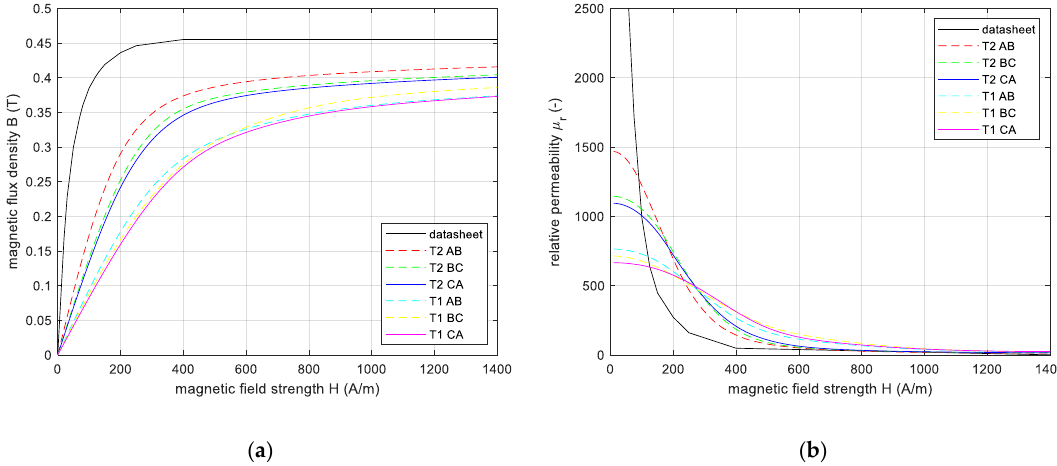
Figure 7. Synthesis of equivalent B ( H ) measurement: ( a ) equivalent anhysteretic B ( H ); ( b ) equivalent relative permeability µ r ; curves based on 3C90 datasheet (black) and measurement: T2 supply of A and B windings (red), T2 supply of B and C windings (green), T2 supply of C and A windings (blue)—the same as in Figure 6, T1 supply of A and B windings (cyan), T1 supply of B and C windings (yellow), T1 supply of C and A windings (magenta).